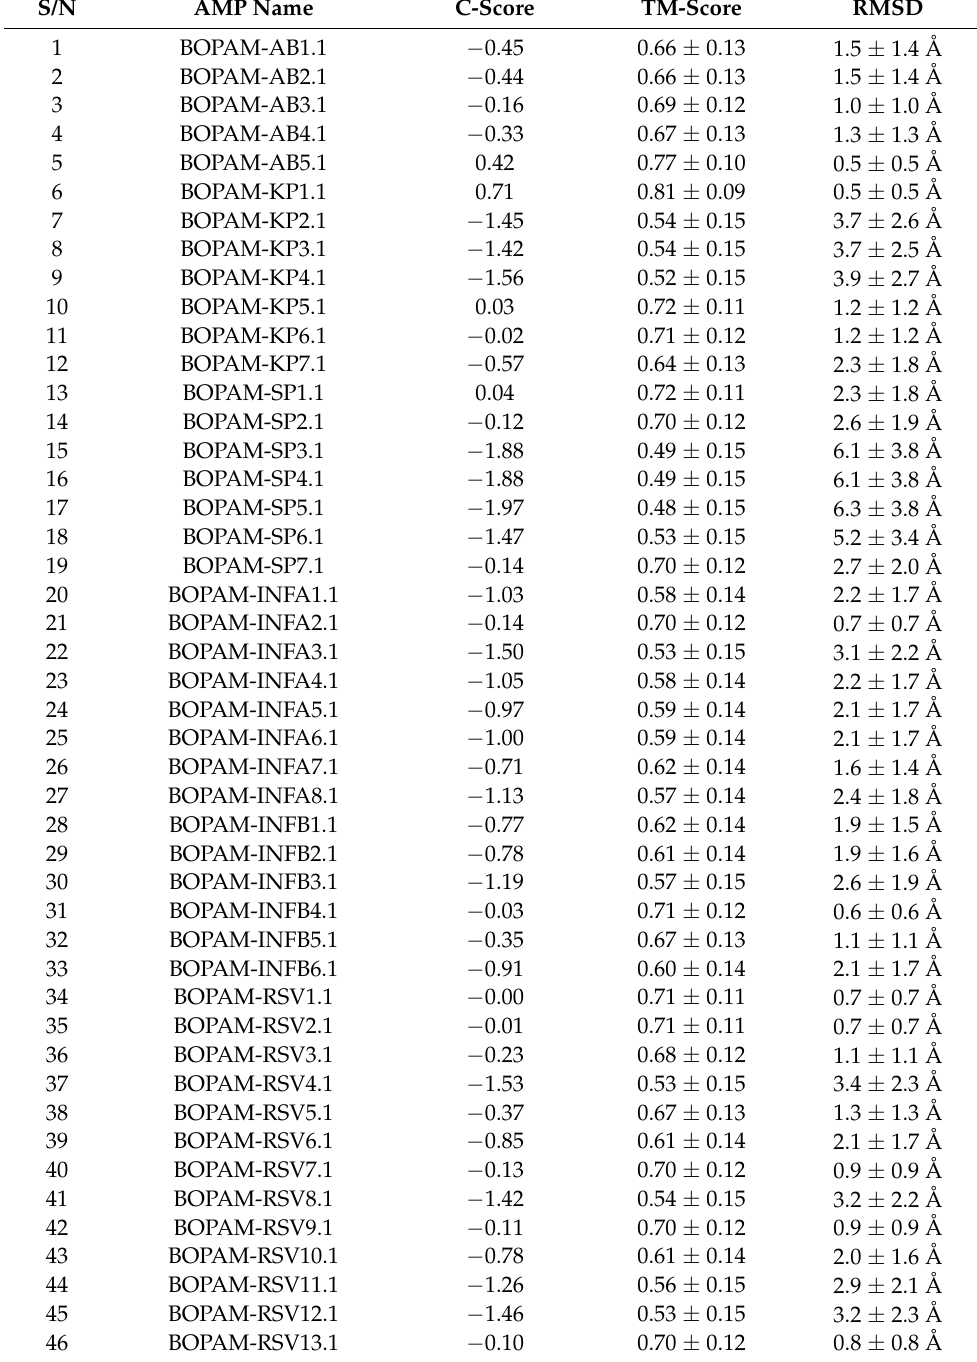
Table 4. Structure prediction scores of the anti-pneumonia